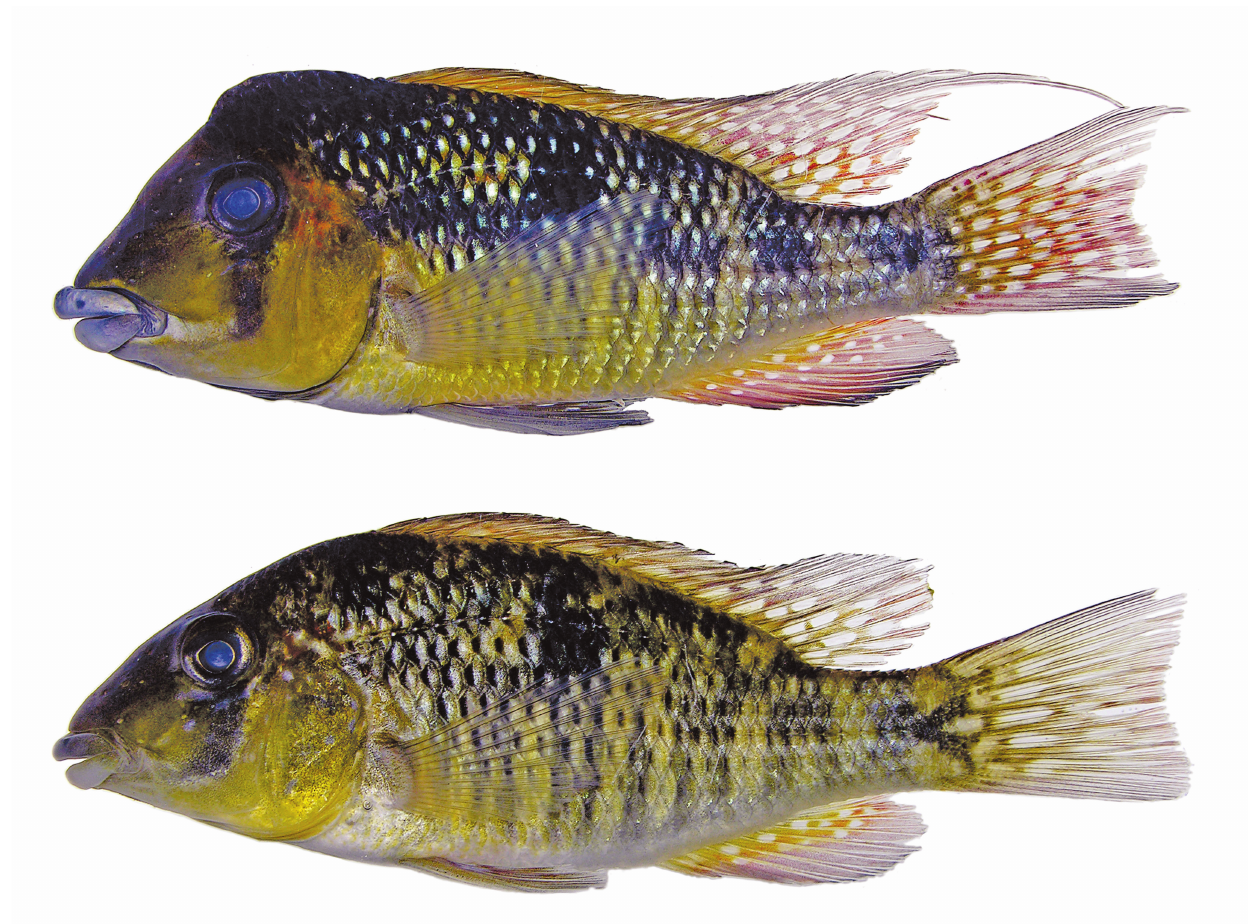
Fig. 4 . Gymnogeophagus peliochelynion : top, holotype, male, ZVC-P 12493, 101.9 SL; bottom, paratype, female, UFRGS 8076, 77.2 SL. Both from arroyo de las Tunas on road 31, tributary of río Arapey Grande, Salto, Uruguay. Photographs taken just after collection and fixation in